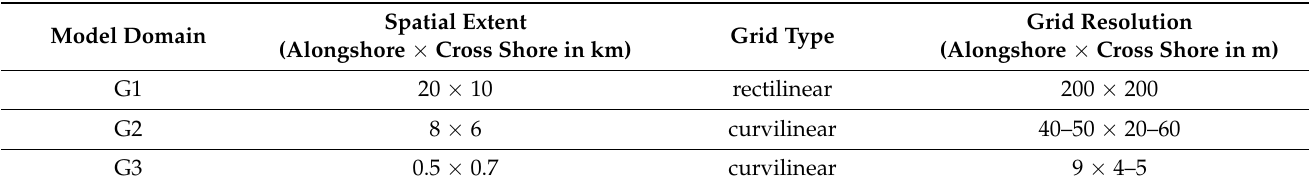
Table 1. Characteristics of the G1, G2, and G3 model domains (Figure